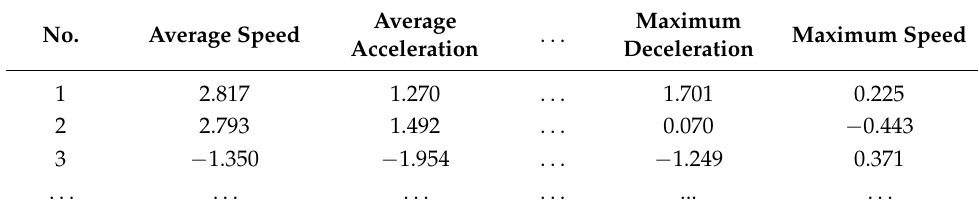
Table 1. The eigenvalues matrix of trolley speed.